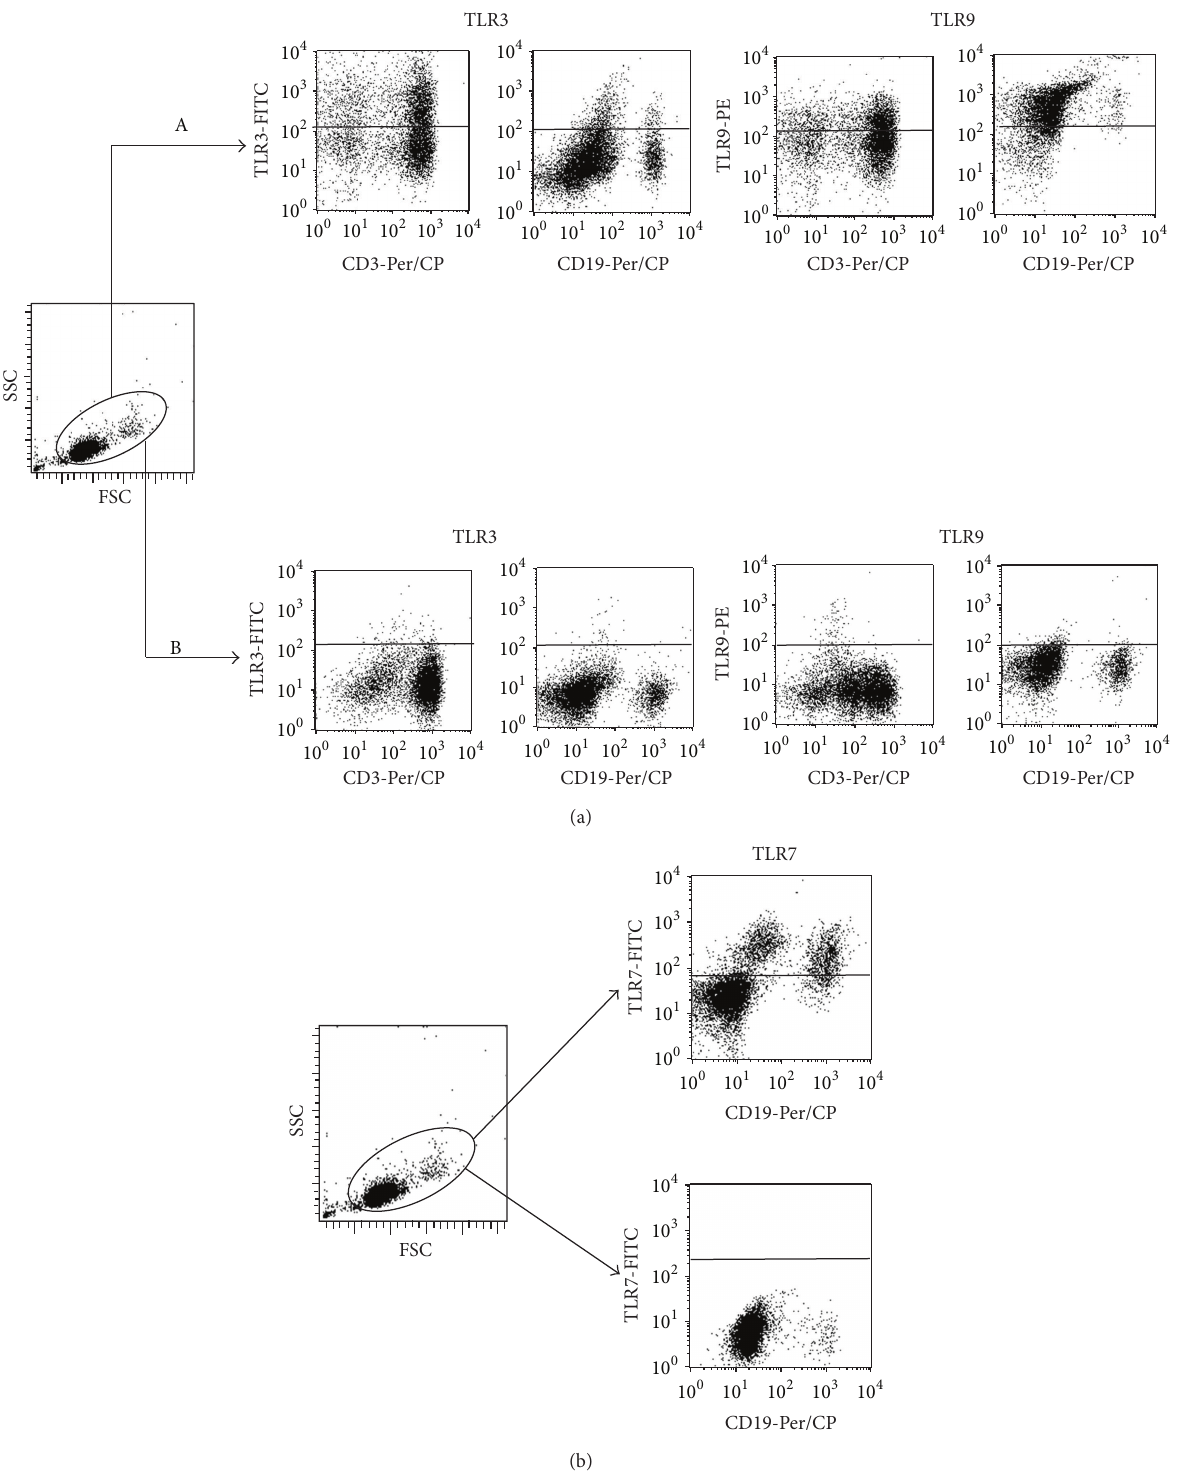
Figure 1: (a) Representative dot plots from flow cytometry measurements of TLR3 and TLR9 expression on T- and B-cells in patients (panel A) and healthy controls (panel B). (b) Representative dot plots from flow cytometry measurements of TLR7 expression on B-cells in patients (upper right dot plot) and healthy controls (lower right dot